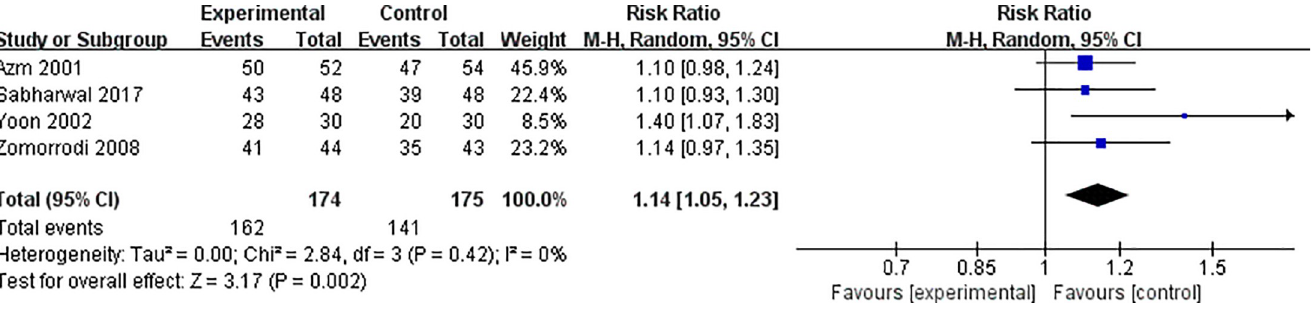
Fig 2. Forest plot for the meta-analysis of